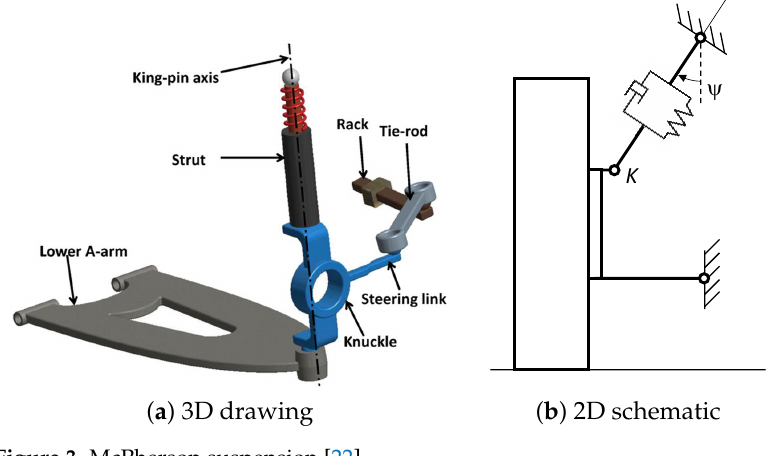
Figure 3. McPherson suspension [22].